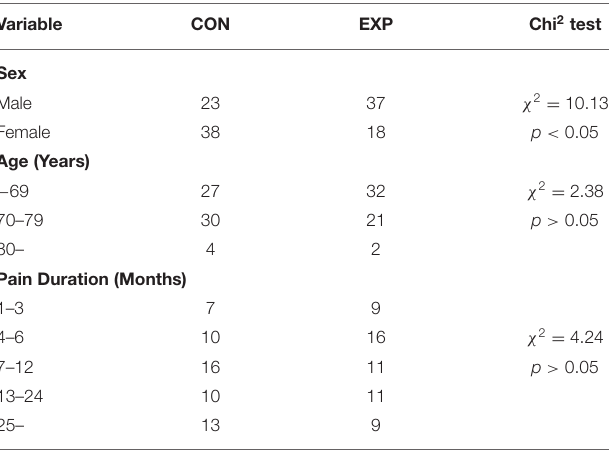
TABLE 1 | General characteristics of the participants.